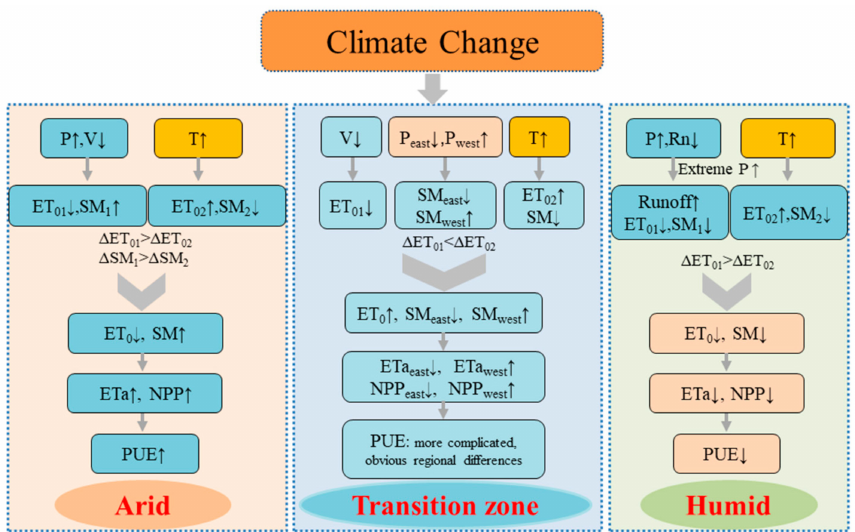
Figure 15. Schematic diagram that illustrates the control factors of the PUE in different climatic regions of